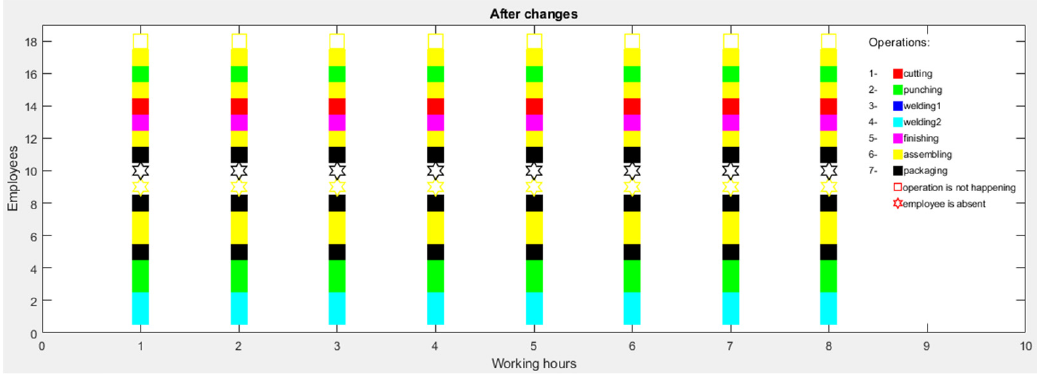
Figure 10. Data after changes, 2nd case.